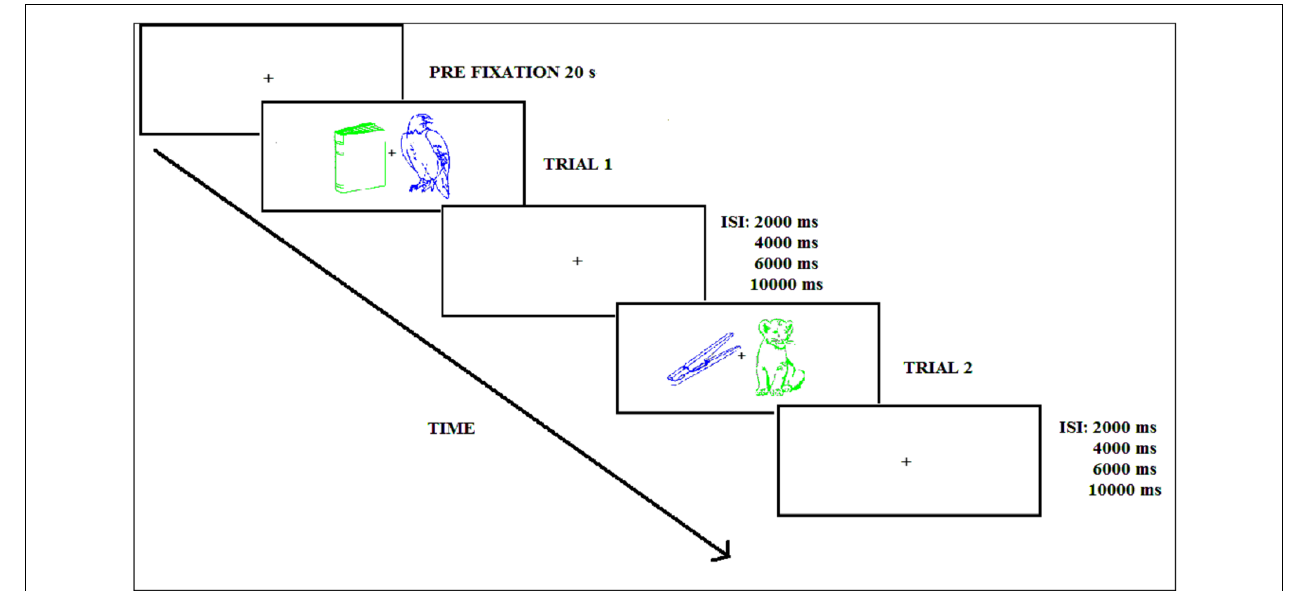
FIGURE 2 | Experimental procedure during the encoding phase (Experiments 1 and 2); ISI refers to the inter-stimulus interval.